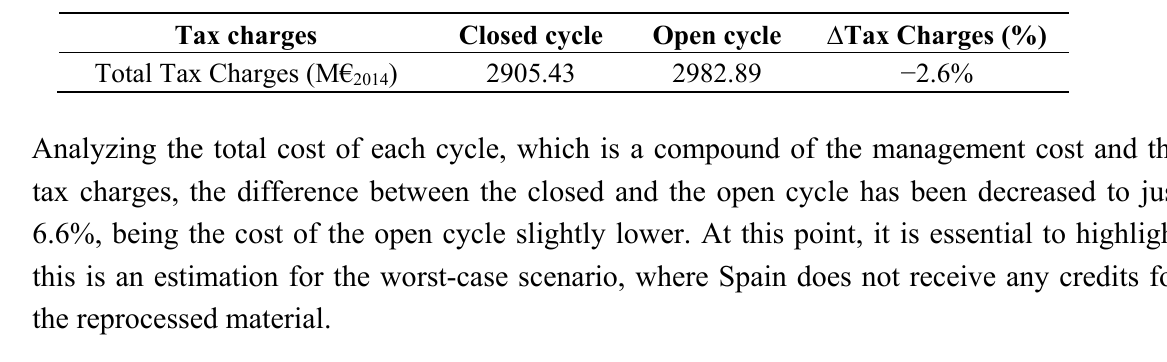
Table 7. Tax charges for the open and closed cycle. Source: Prepared by the author